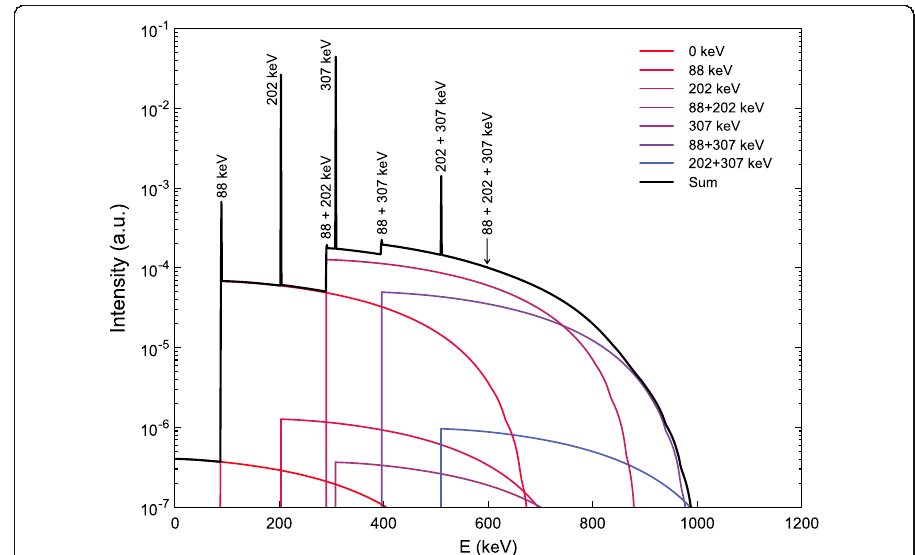
Fig. 5 Coincidence energy spectra as predicted by the analytical calculations for two detectors with d = 2.5 cm. The different distributions in color are the resulting β − energy spectrum shifted and normalized to the corresponding energy value for each possible interaction combination. The black line is the resulting energy spectrum from summing the β − distributions from the source crystal and the γ -rays from the isomeric transition interactions in the detector crystal. The energy value of the peaks arising from the detection of one, two, or three γ -rays are indicated in the figure (see text for